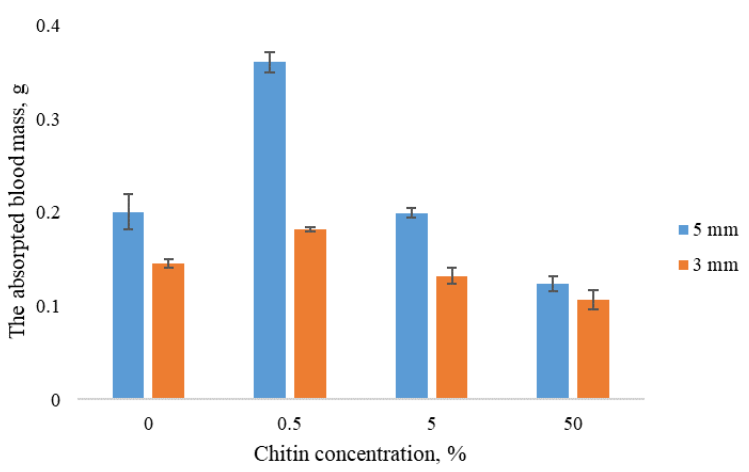
Figure 2. Blood absorbance by sponges vs . ChNF content in samples.